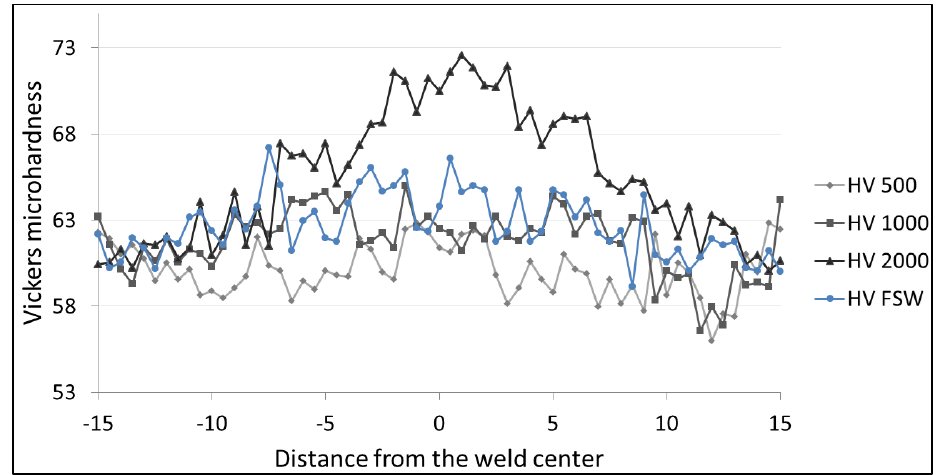
Figure 16. Microhardness profile across FSW and LFSW welds at 1.5 mm from the top surface.